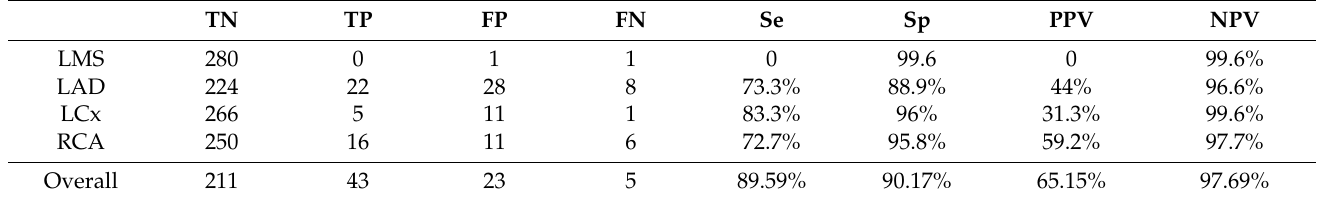
Figure 3. Repartition of patients by CAD-RADS score. Table 2. Diagnostic performance of CCTA compared to ICA for analyzable patients ( n =